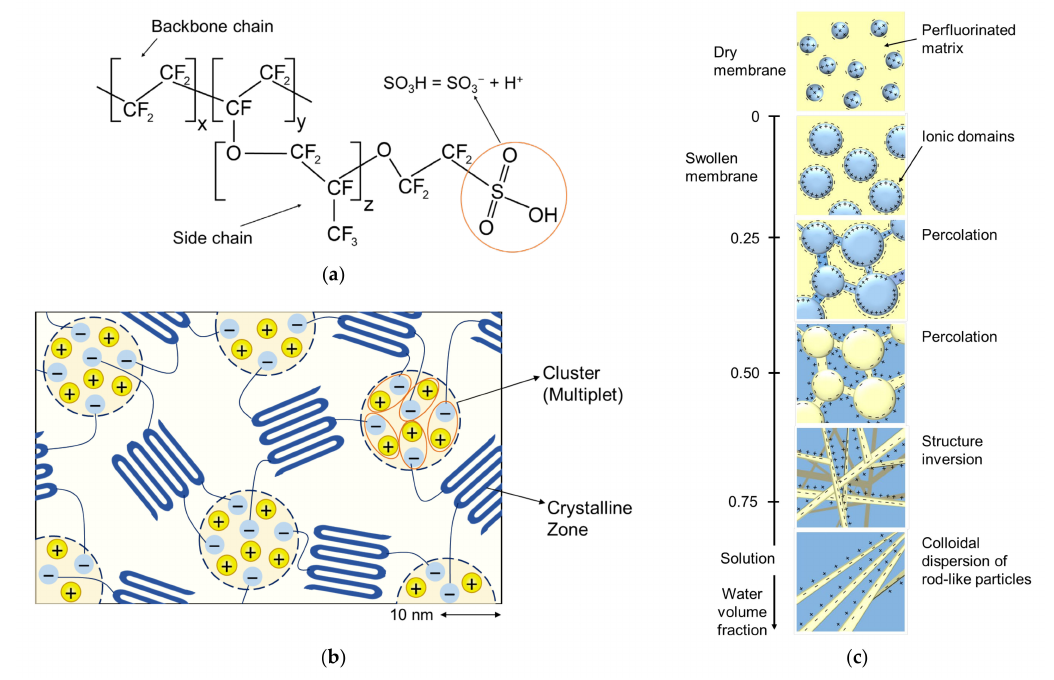
Figure 5. A perfluorinated sulfonated polymer (supra)molecule ( a ). Formation of nanoclusters in the dry state of a perfluorinated sulfonic-acid polymer ( b ) (redrawn from [47]). Evolution of the nanostructure of such a polymer during hydration ( c ) (redrawn from